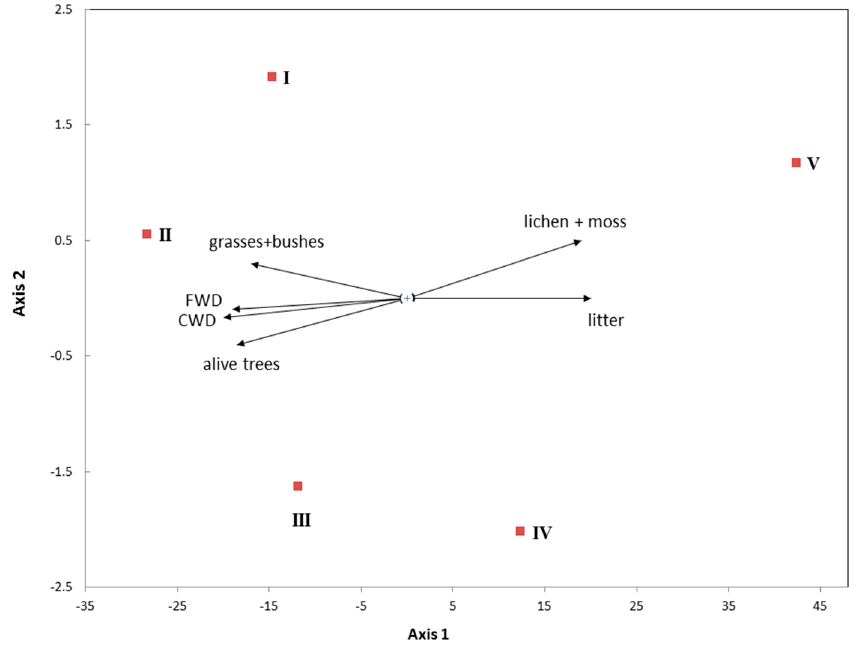
Figure 8. Relationship between different ecological groups of fungi or groups with substrate preference with plant biomass and mortmass in the altitudinal levels (I–V).